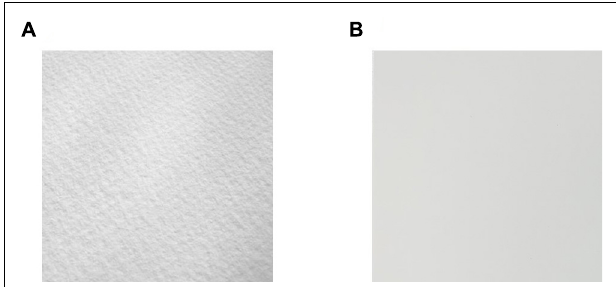
FIGURE 1 | Rough and Smooth paper used as stimulus in the main study. (A) iPhoto S Morrow Coarse, size 100 × 148 mm, thickness 300 g/m